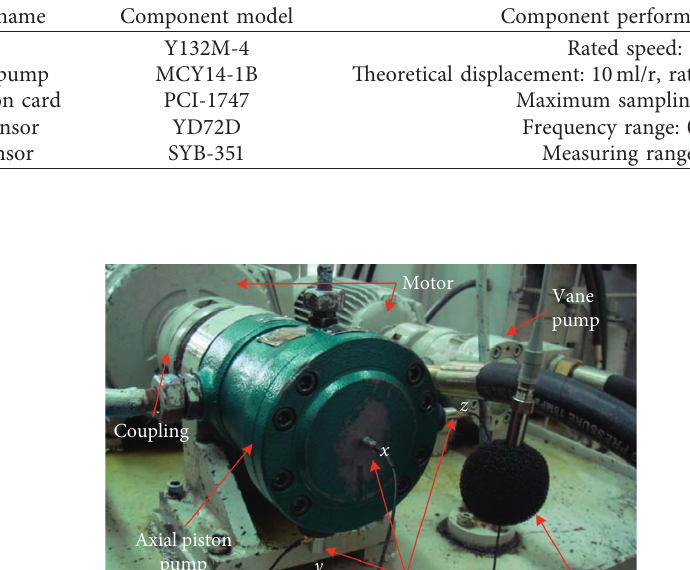
Table 4: Types and performance parameters of test components. Num.